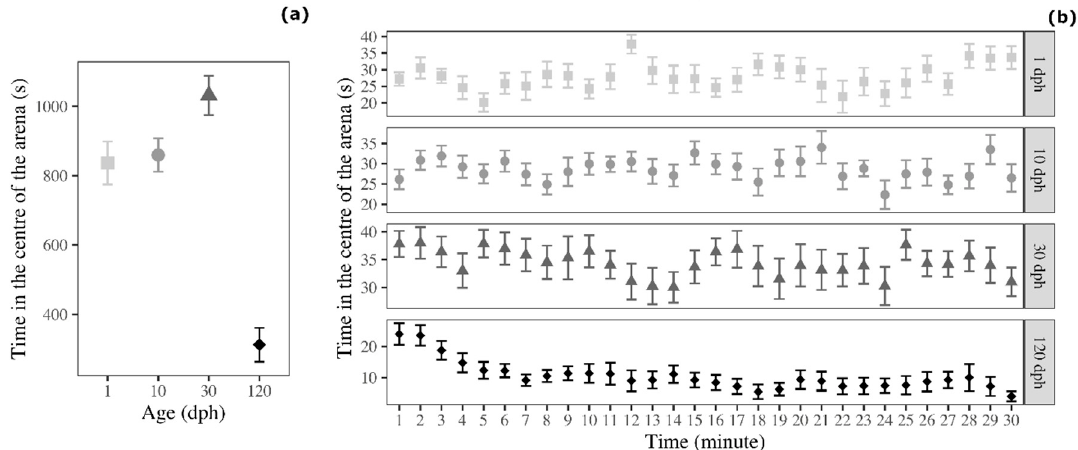
Figure 4. Time spent by medaka in the centre of the arena in the open-field test ( a ) as a function of age and ( b ) as a function of age and time (30 1 min time bins). Points represent means of the different age groups (squares = 1 dph, circles = 10 dph, triangles = 30 dph, and rhombuses = 120 dph) and error bars represent standard errors ( n = 16 per age-group).